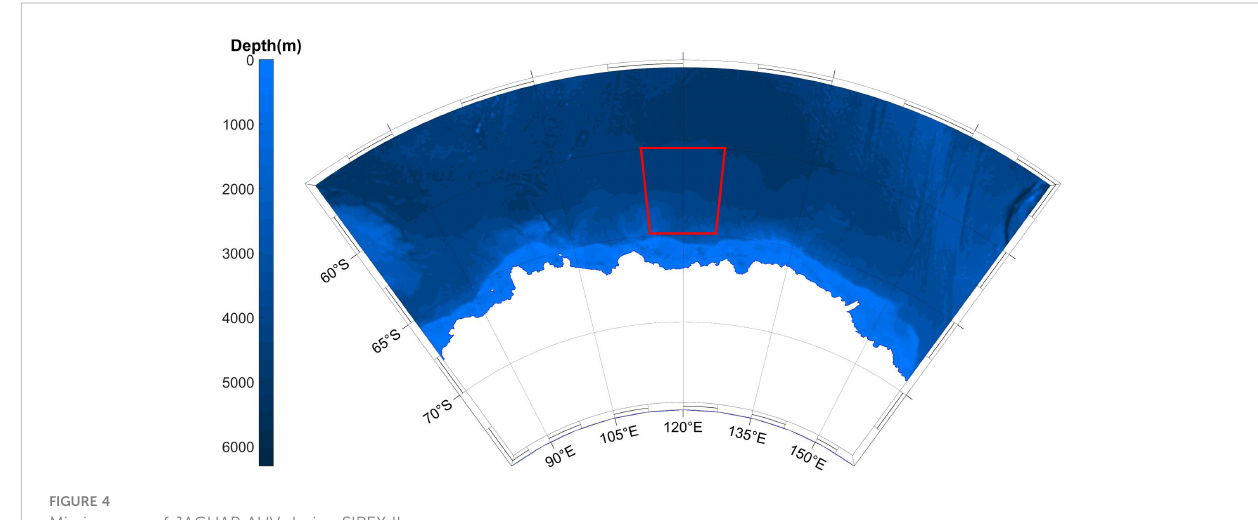
FIGURE 4 Mission area of JAGUAR AUV during SIPEX II